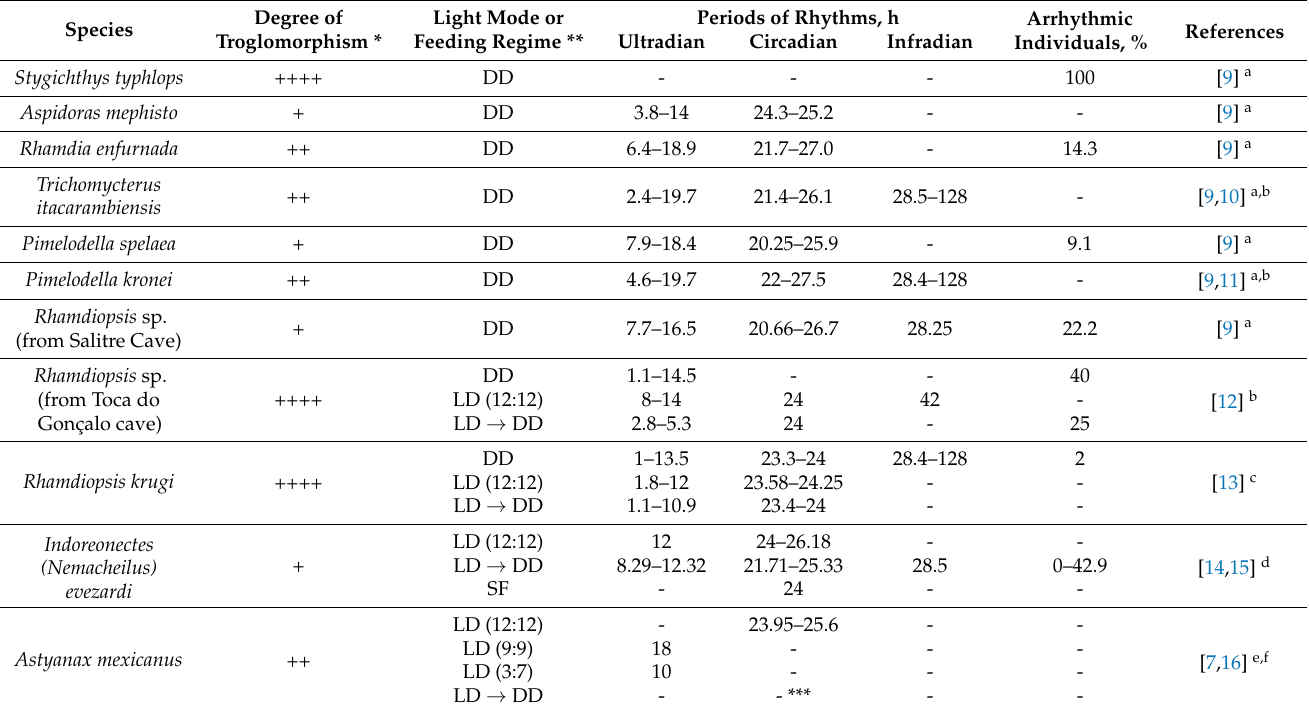
Table 1. Rhythms of locomotor activity in